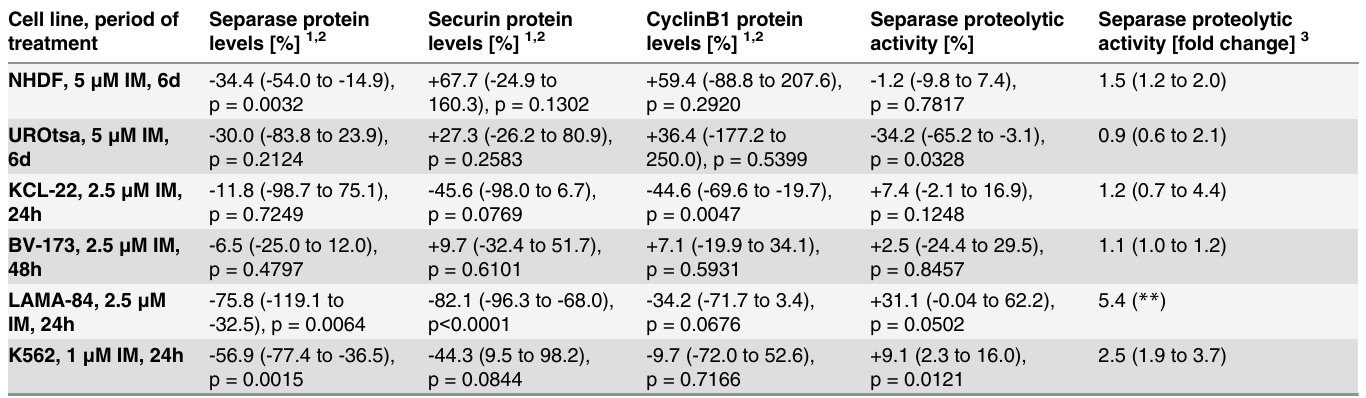
Table 4. Percent changes ( Δ -values are differences between means) in protein levels and proteolytic activity of Separase after IM treatment when compared to corresponding untreated cells. Cell line, period of